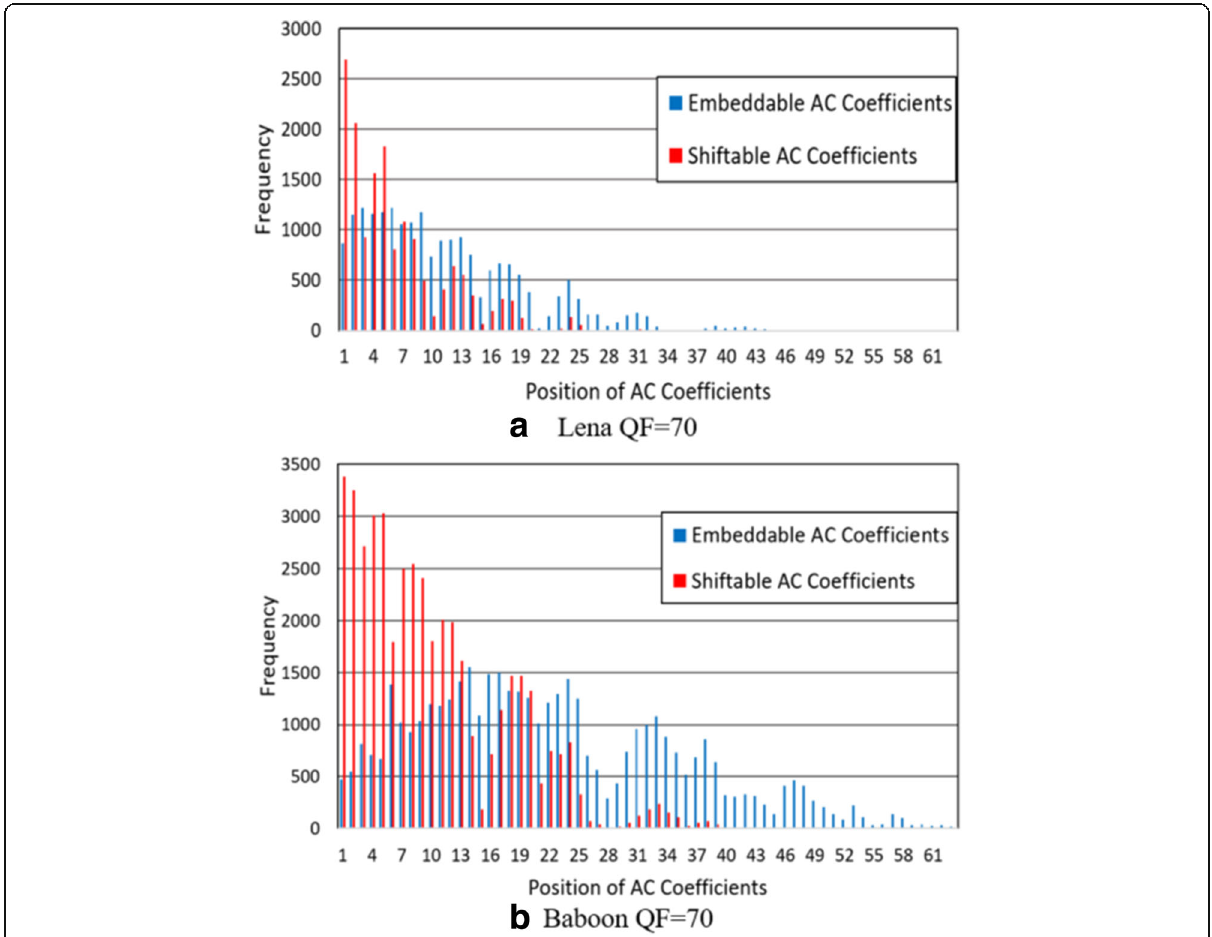
Fig. 3 Number of embeddable and shiftable AC coefficients on each